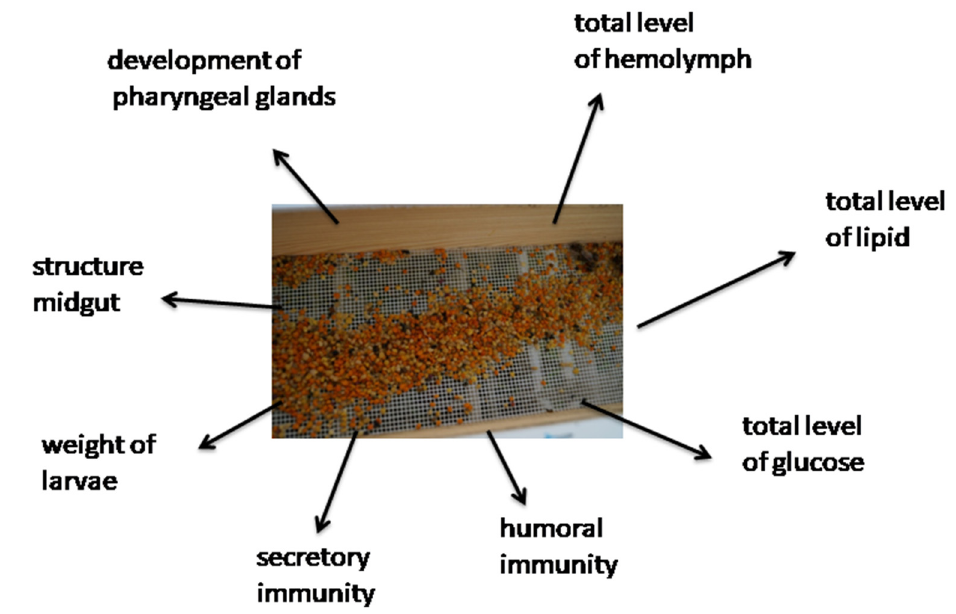
Figure 3. Influence of pollen diet on a honey bee. Table 1. Influence of pollen diet on the hypopharyngeal glands and hemolymph (based on the literature [7,20,37,40]). Type of Pollen/Parameter